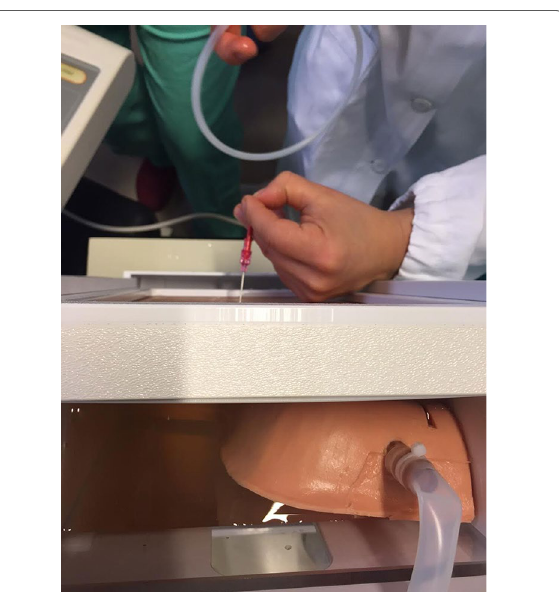
Fig. 2 The open top of the Ultrasound Thoracentesis Model. The model’s open top allows the instructor to provide feedback on procedural concepts, offering students the possibility to visualize the catheter depth and placement once inserted into the pleural cavity. This characteristic was used by the investigators to evaluate the performance of each